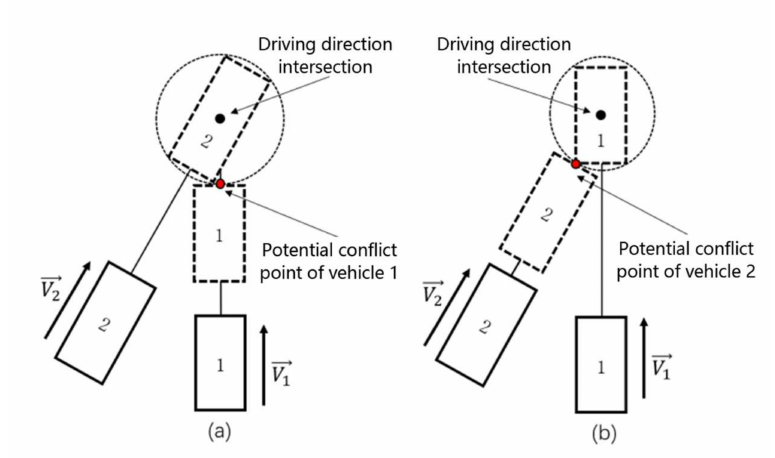
Figure 6. Schematic diagram of a cross-conflict considering vehicle dimensions. ( a ) potential conflict point of vehicle 1, ( b ) potential conflict point of vehicle